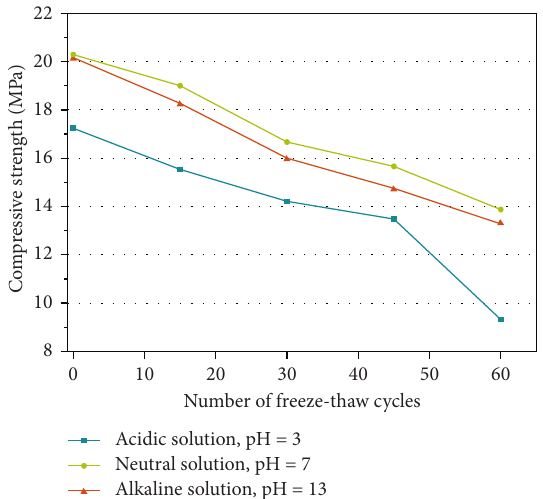
Figure 6: Relationship curves between the compressive strength of sandstone samples and the number of freeze-thaw cycles under different chemical solution